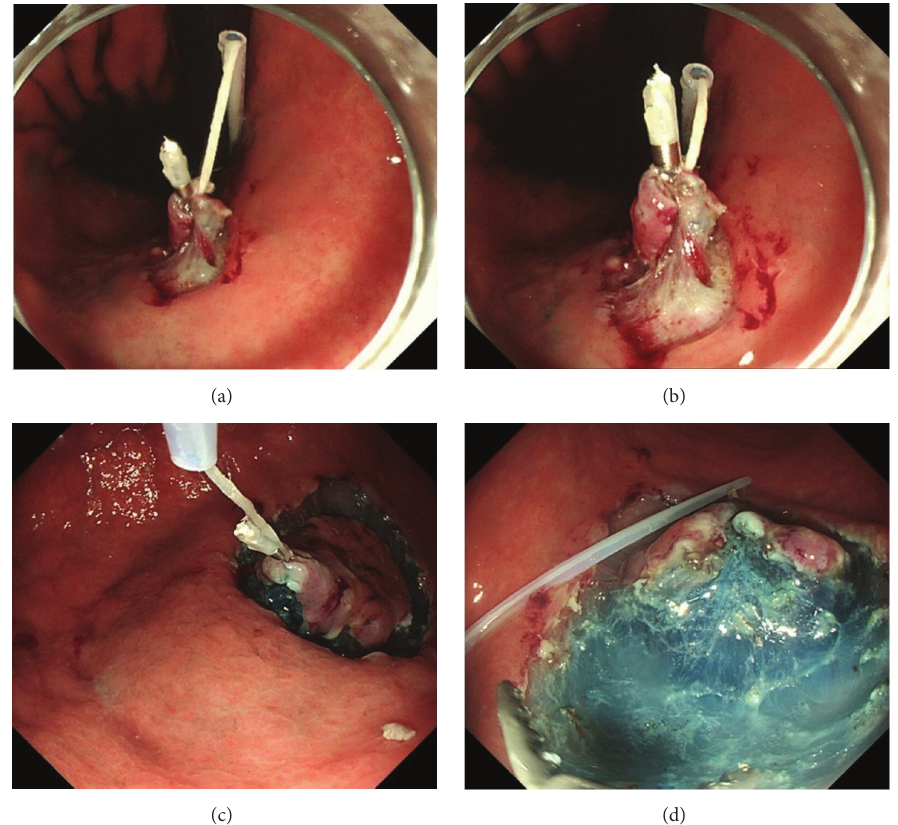
Figure 3: After circumferential mucosal incision, the clip with the thread covered by the sheath is attached to the edge of the lesion, including both the mucosal and submucosal layers (a). The thread-traction methods using a sheath of polypectomy snare (TTSPS) allow independent movement of the thread and the endoscope, and traction force can be easily controlled without interfering with the movement of the endoscope (a and b). The lesion can be pulled not only towards the oral side (c) but also towards the anal side by positioning the sheath over the anal side of the lesion (d). In the TTSPS method, countertraction can be easily applied to the anal side of the tumor, and the submucosal layer of the tumor is clearly visible when the tumor is located in the antrum (c and d).